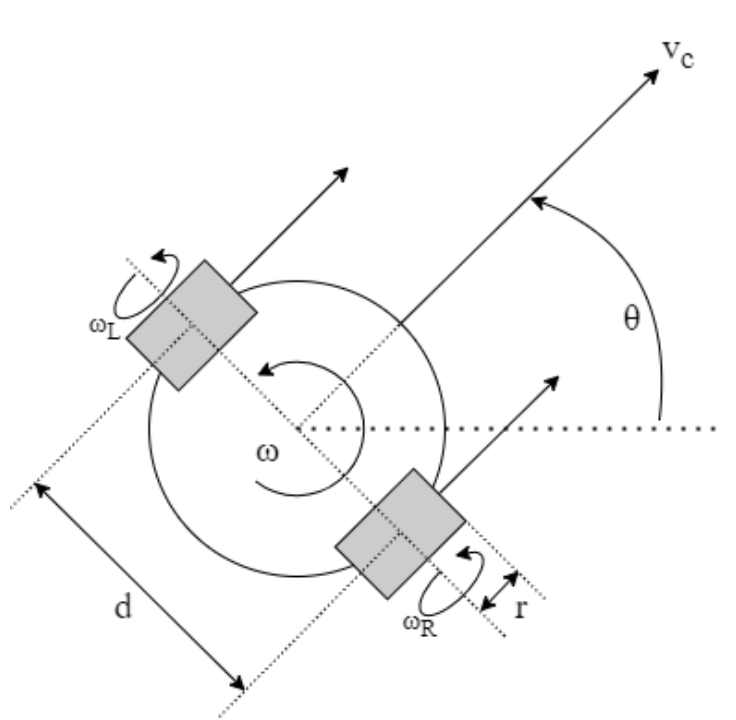
Figure 1. Geometric representation of kinematics of the differential